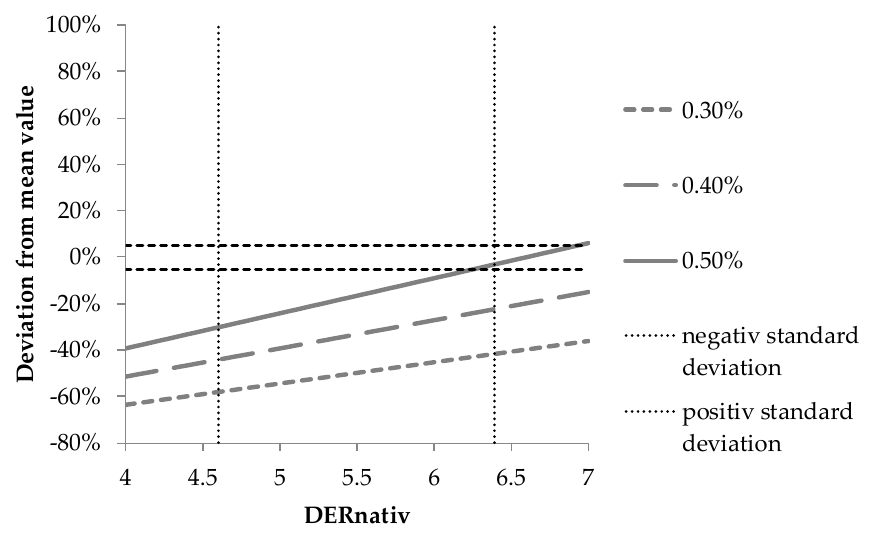
Figure 4. DER deviation derived by herbal raw content nature and definition range [50].